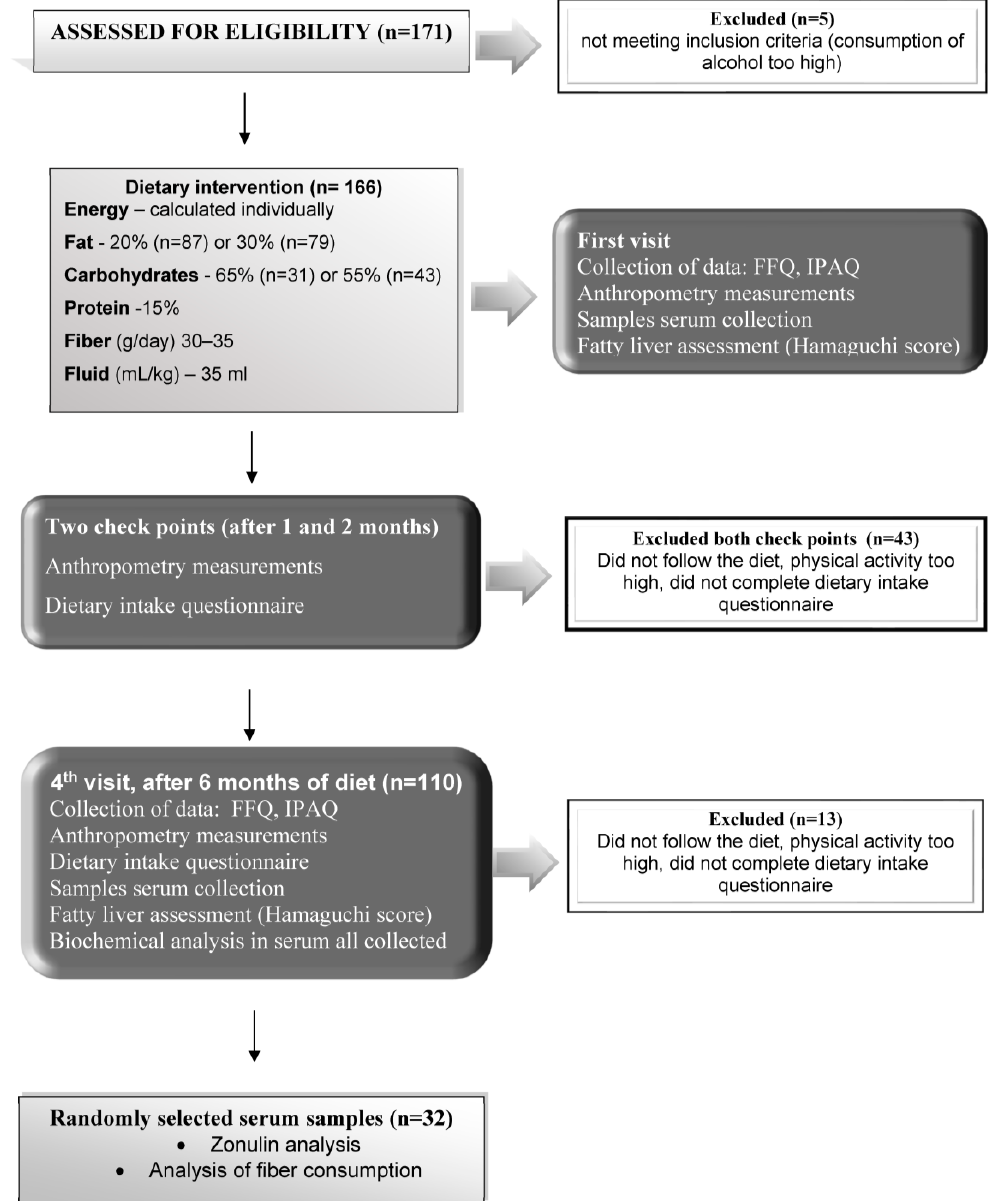
Figure 1. Flowchart for the inclusion of individuals in the study.